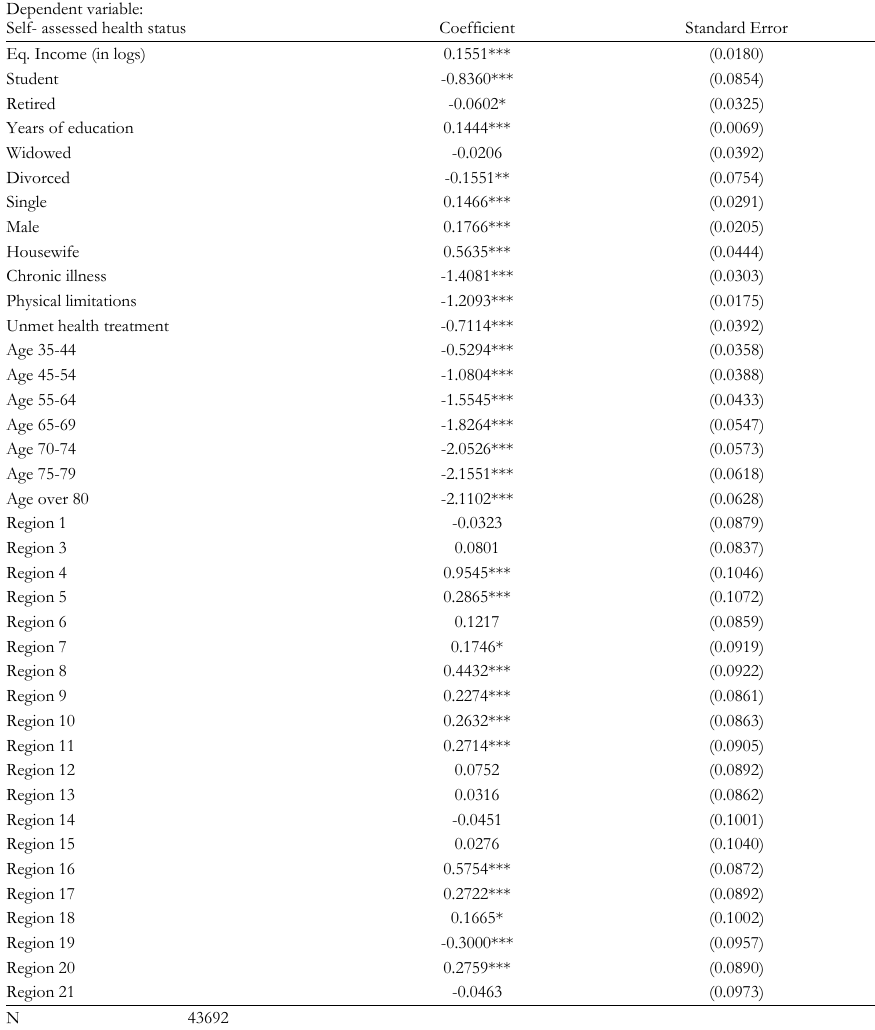
Ordered logit estimation of self-assessed health status (year 2007) Dependent variable: Self- assessed health